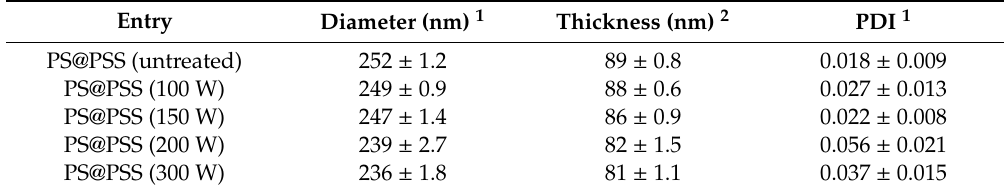
Table 2. Size of PS@PSS after homogenizer treatment under different powers.